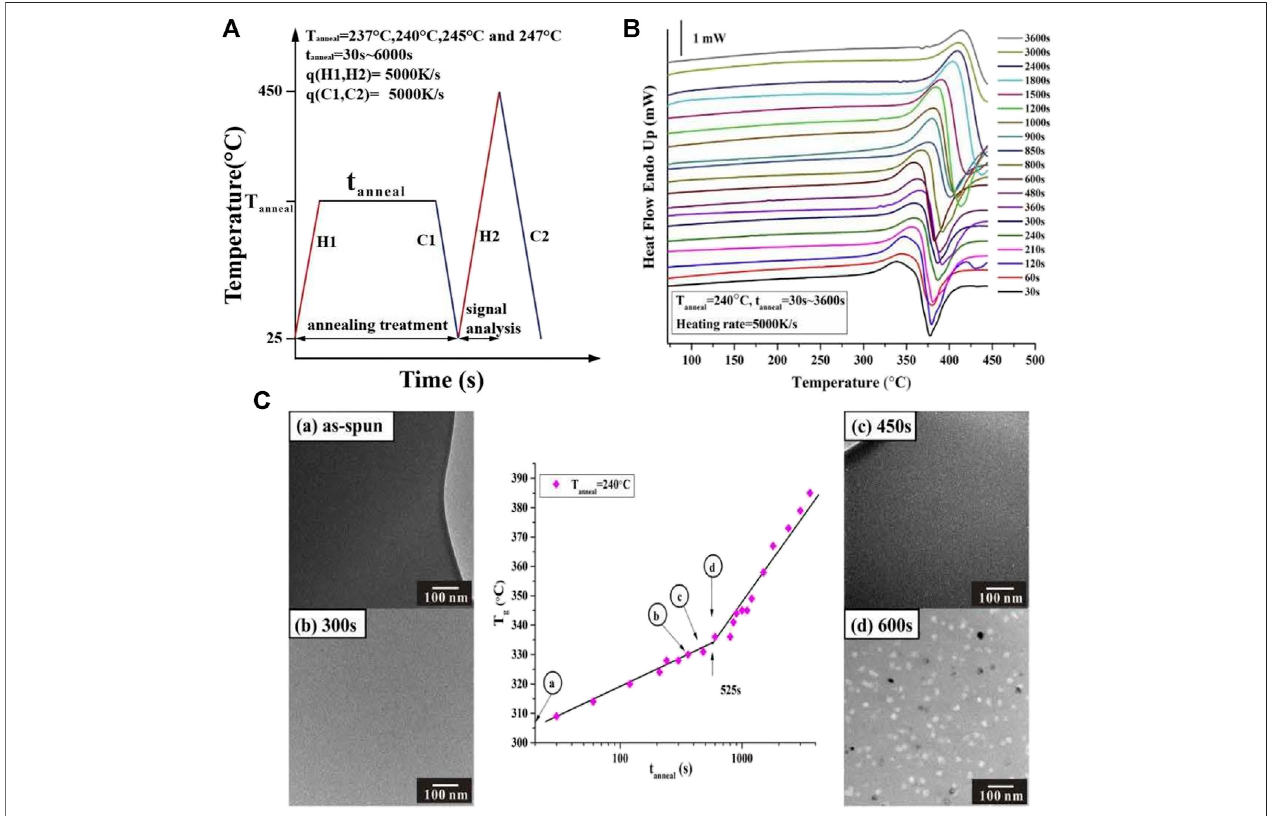
FIGURE3|(A) FlashDSCtemperature-timepro fi lefordeterminingthenucleationdelaytimeforAl 88 Y 7 Fe 5 MG. (B) FlashDSCheat fl owcurvesat240 ° Cforaseries of annealing times from 30 to 3,600 s under same heating rate of5000 K/s. (C) Tg vs. log (tanneal) plot for Al 88 Y 7 Fe 5 at Tanneal (cid:2) 240 ° C. At 525 s, the evolution path of Tg with tanneal appears a transition from the structuralrelaxation and composition change and this transition point isthe delay time at 240 ° C. Fgures (A) – (D) display the TEM results corresponding to different annealing states with the annealing time shorter (A,B,C) and longer (D) than the deal time, respectively, (from Shen et al.